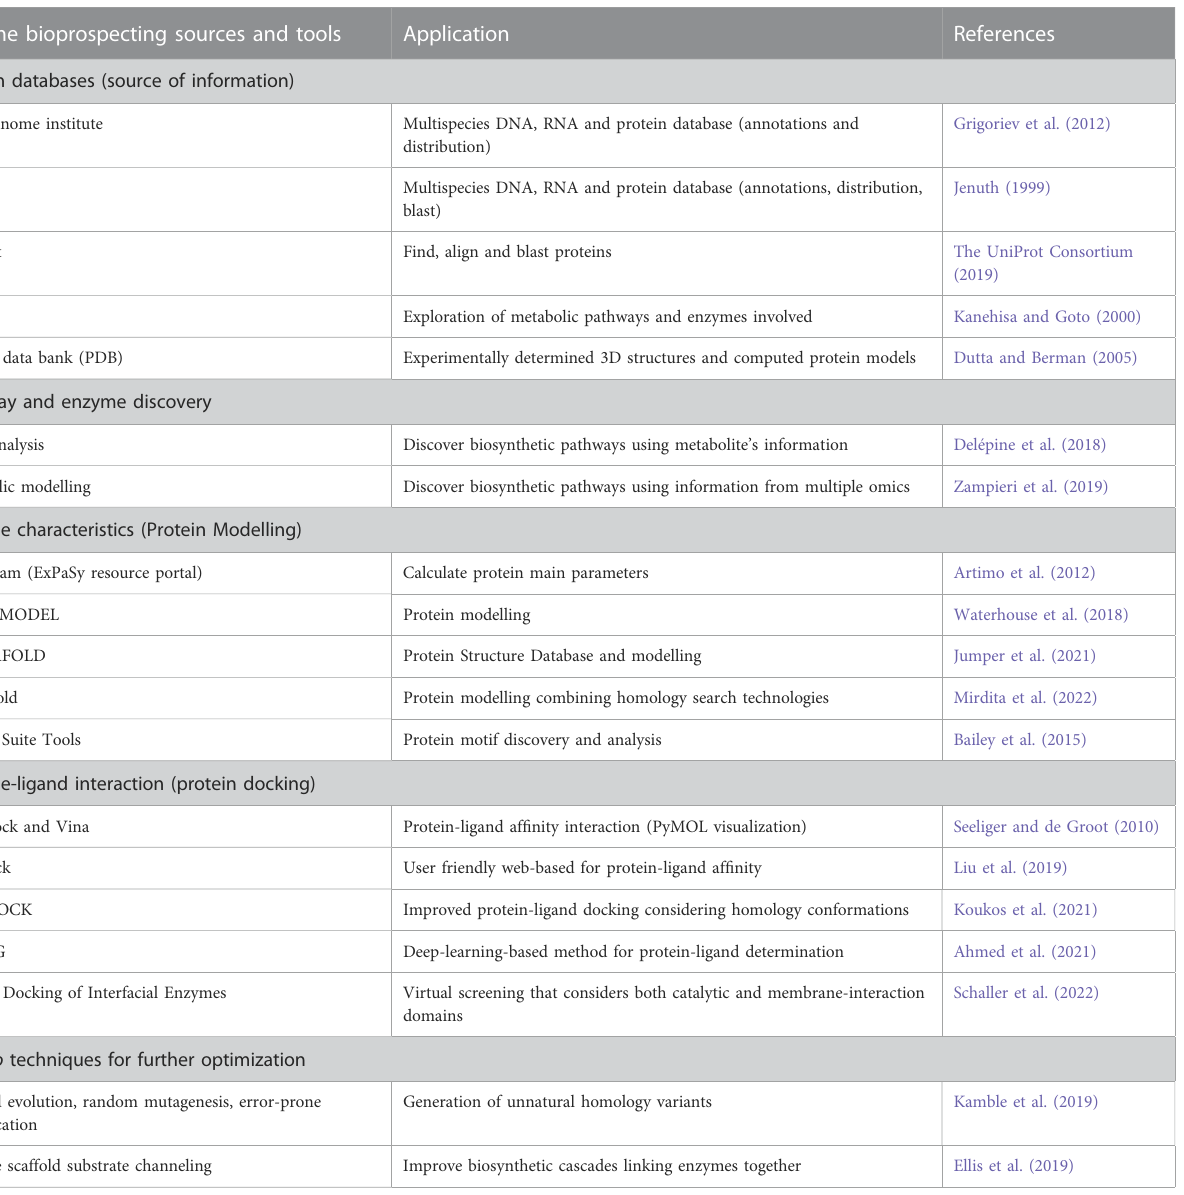
TABLE 2 Online sources and tools for enzyme bioprospecting. Enzyme bioprospecting sources and tools Application